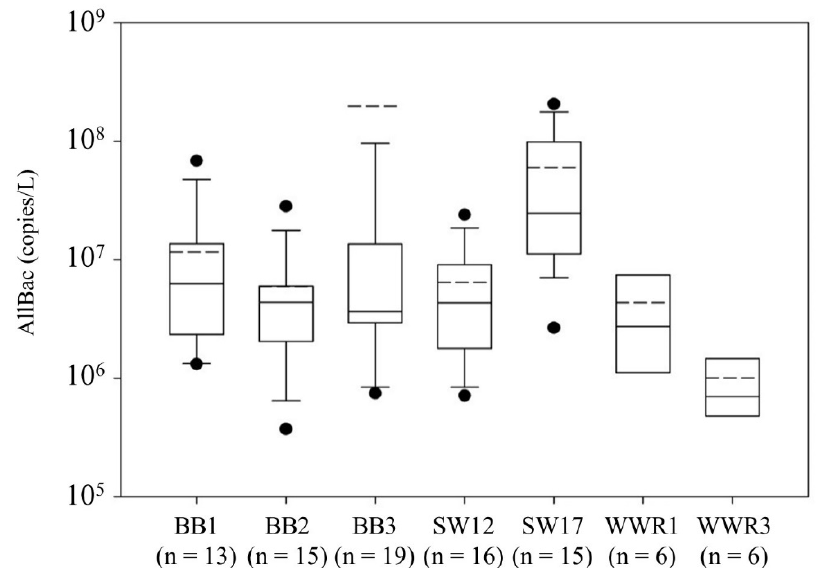
Figure 1. Box plot depicting AllBac concentrations (copies/L) at each site. The boundary of the box closest to zero indicates the 25th percentile, the solid line within the box represents the median, the dashed line represents the mean, the boundary of the box farthest from zero indicates the 75th percentile, the whiskers above and below the box indicate the 10th and 90th percentiles, and the circles indicate outliers (note that y-axis has been truncated to allow clearer observation of differences among sites resulting in outlier at BB3 (3.5 × 10 9 gene copies/L) not being shown).